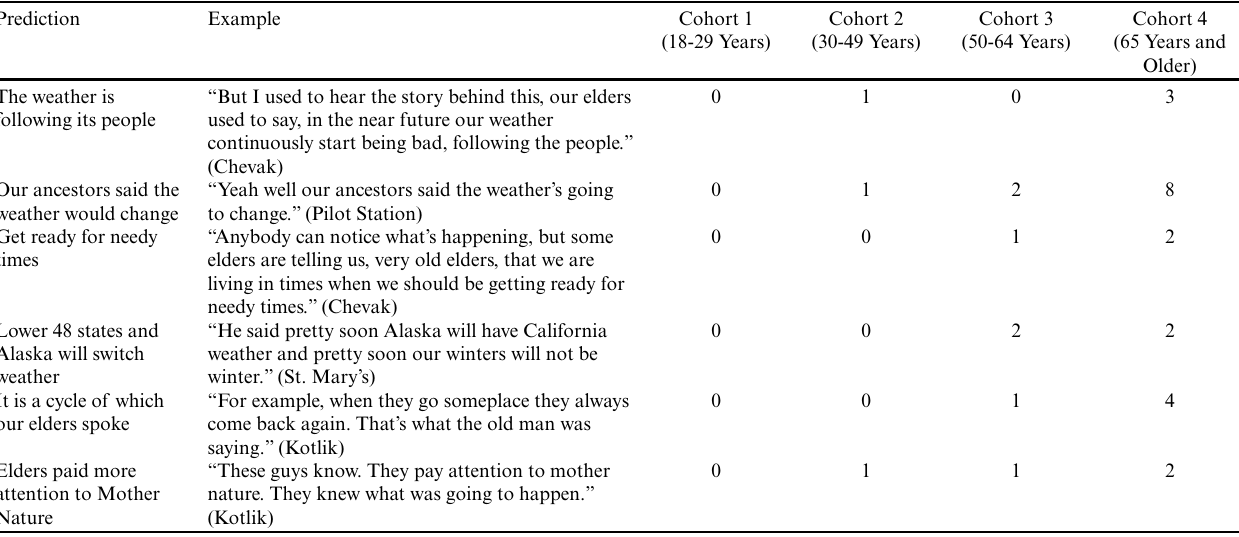
Table 7 . Number of times elder-predicted change was spoken of by each age cohort.